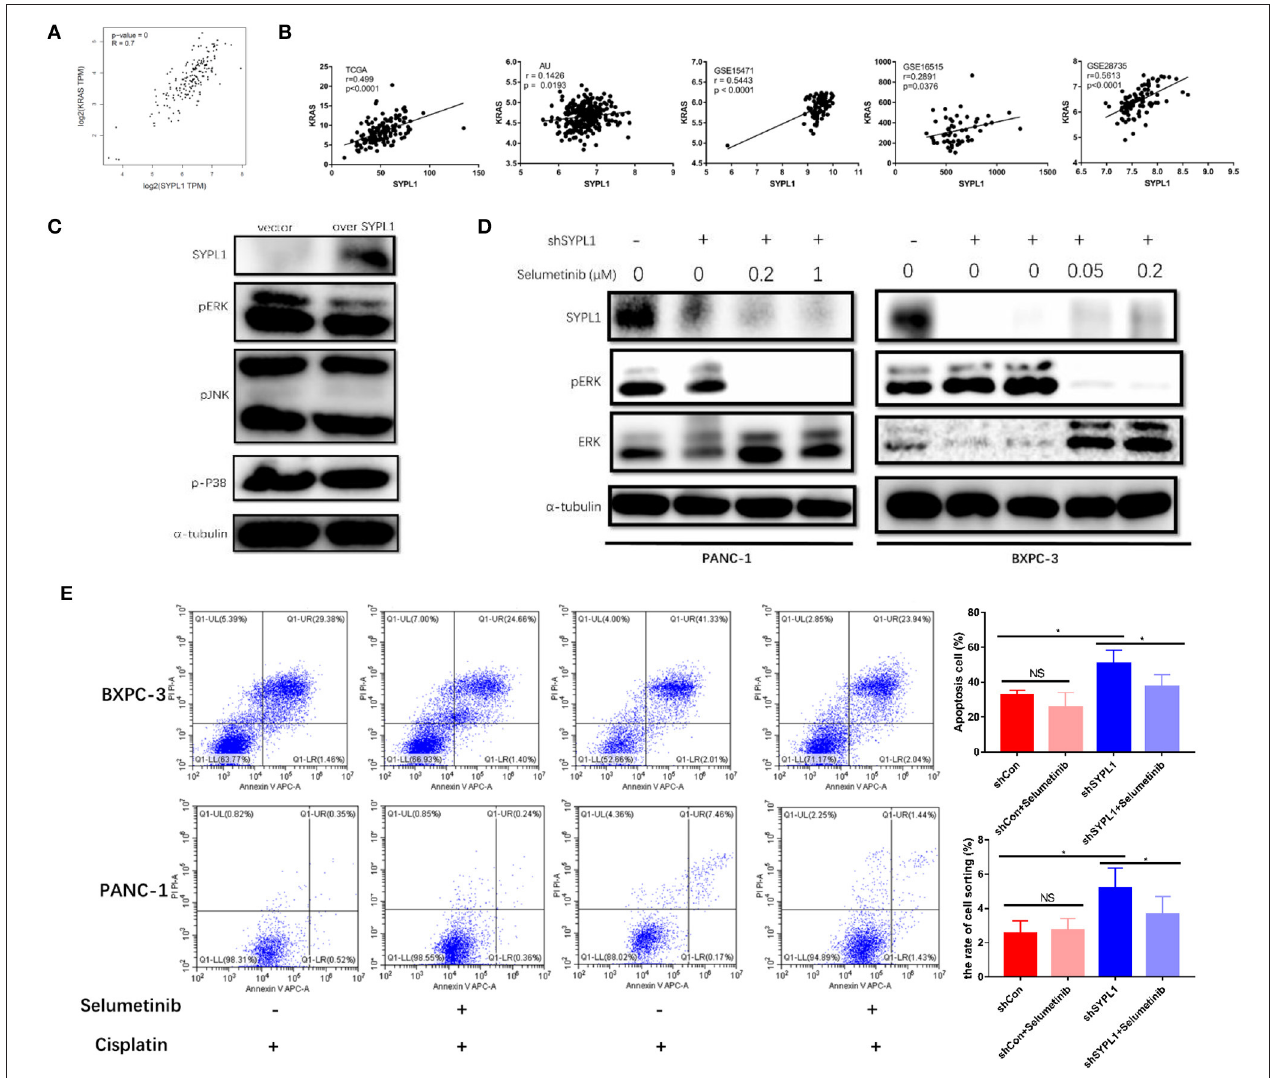
FIGURE 6 | Knockdown of SYPL1 led to cell death by activating ERK. (A) We found that KRAS was one of the genes with the highest positive correlation to SYPL1 in the GEPIA database. (B) The positive correlation between the expression of SYPL1 and KRAS was validated in GSE15471, GSE16515, GSE28735, and PACA-AU. (C) When SYPL1 was overexpressed, phosphorylated ERK (pERK) was downregulated, while phosphorylated P38 and JNK did not change significantly. (D) In BXPC-3 and PANC-1 cells with knockdown of SYPL1, upregulation of pERK and downregulation of total ERK were observed, which indicated ERK activation. Selumetinib counteracted the activation of ERK. (E) Flow cytometry showed that selumetinib protected cells from downregulated SYPL1-induced cell death. * p <